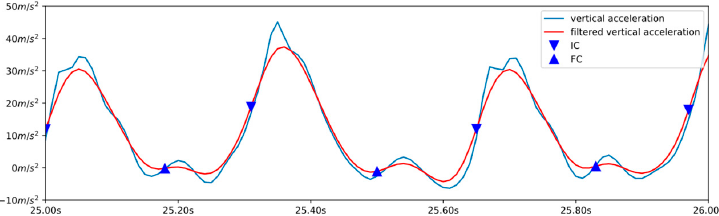
Figure 7. Blue line: vertical acceleration obtained from the upper-arm-mounted inertial sensor. Red line: low pass filtered vertical acceleration. IC and FC events are indicated by a downward triangle and an upward triangle, respectively.